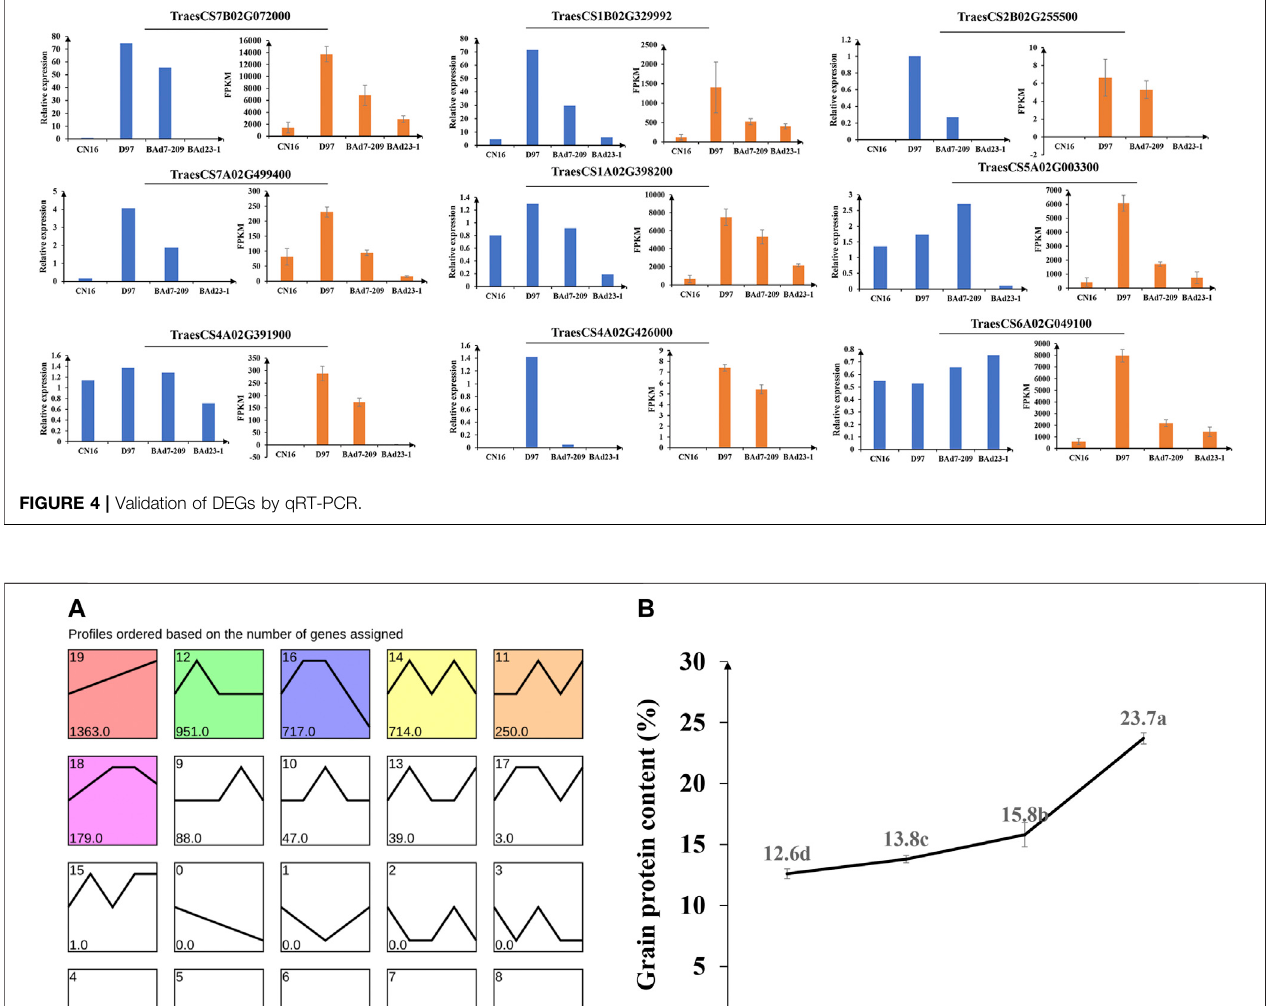
Frontiers in Genetics |